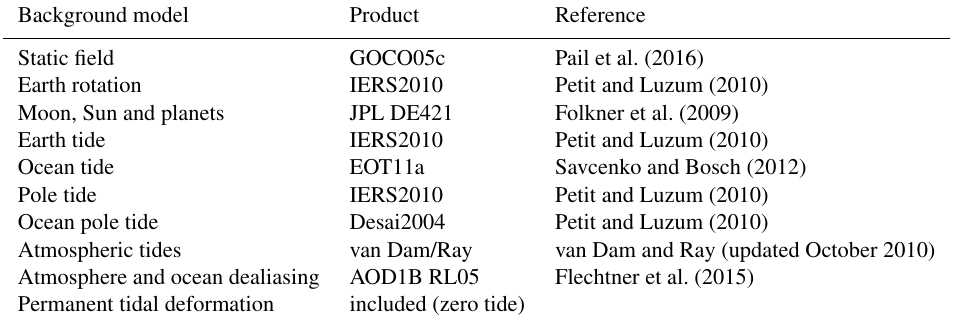
Table 2. Background models used during the